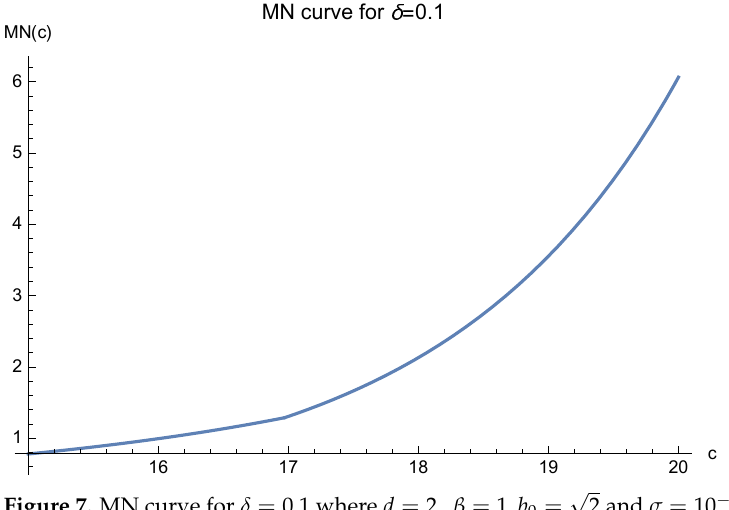
Figure 7. MN curve for δ = 0.1 where d = 2, β = 1, b 0 =